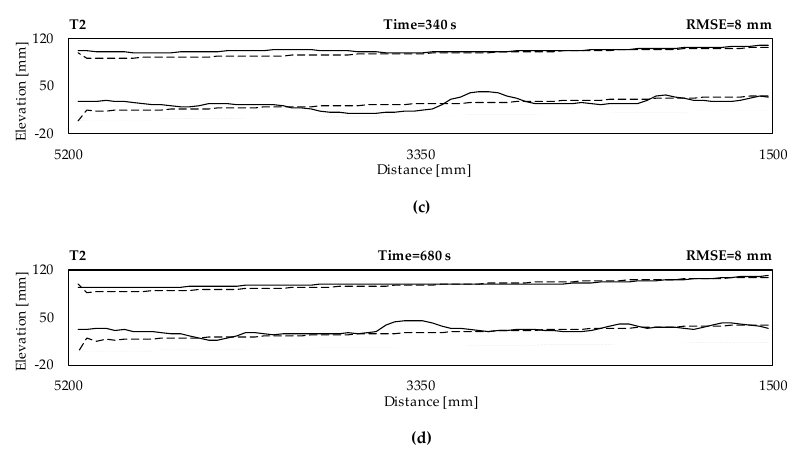
Figure 4. Longitudinal bed and water profiles for the experiment T2 obtained experimentally (continuous) and numerically (dashed) at (a) 0 s, (b) 170 s, (c) 340 s, and (d) 680 s. The horizontal axis represents the stream-wise distance from the inlet, whereas the vertical coordinates were measured with respect to the initial bed surface elevation at the channel outlet. The longitudinal bed profile at 0 s is represented by the gray line. Flow is from right to left.